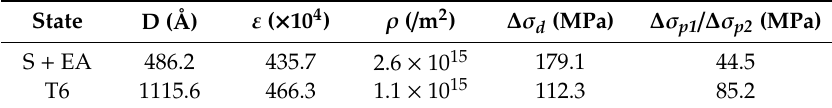
Table 4. Necessary parameters for the calculation of dislocation density and the detailed contribution to yield